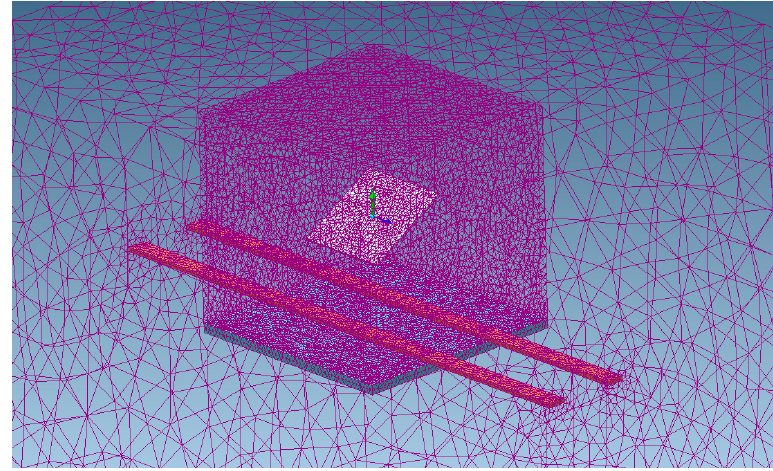
Figure 3. Mesh of the FE model.